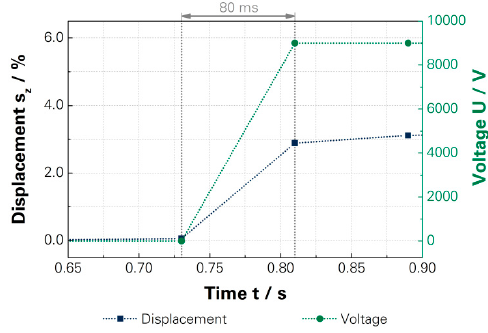
Figure 7. Investigated reaction time of a standard DEA [15]—Table S1: actuator 1.